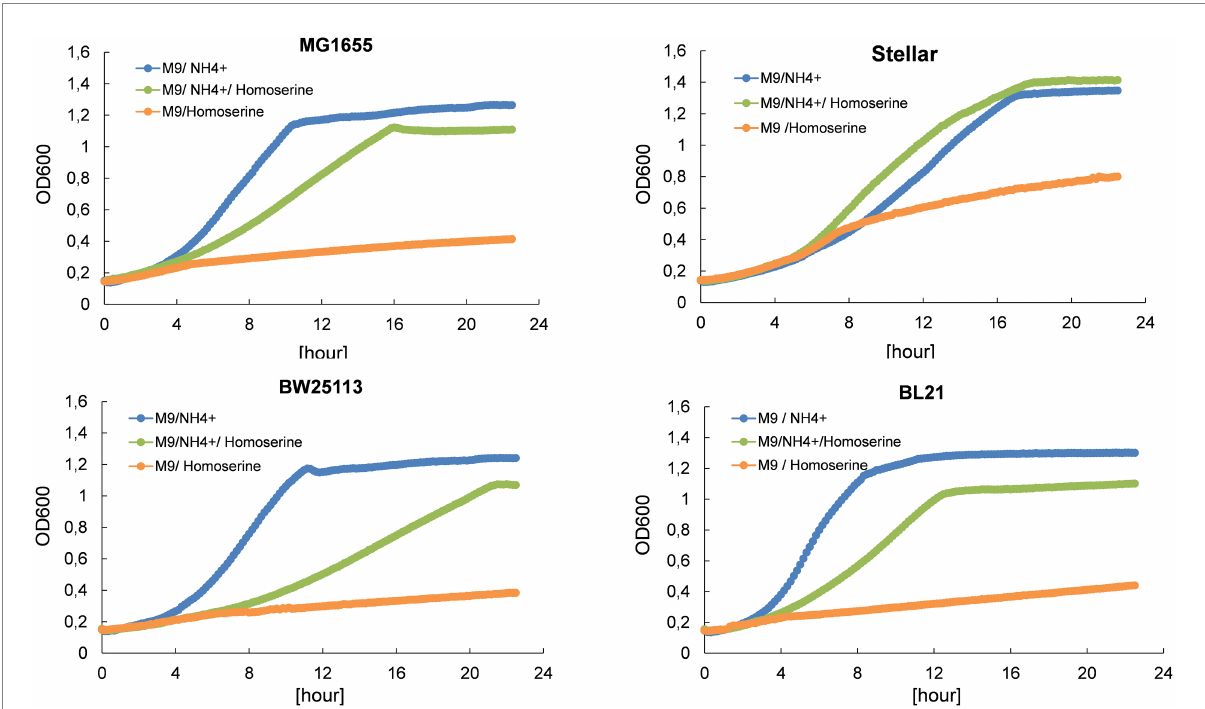
FIGURE 1 L-homoserine is not a nitrogen source for growth of E. coli and causes growth inhibition when added to a mineral medium containing another source of nitrogen (ammonium ions). The growth was carried out in M9 medium buffered at pH 7.0 with 100 mM MOPS containing 0.4% (w/v) glucose at 30 ° C in a Biotek microplate reader. L-homoserine was added at 15 mM. Growth curves for each strain and each condition are the mean of three technical